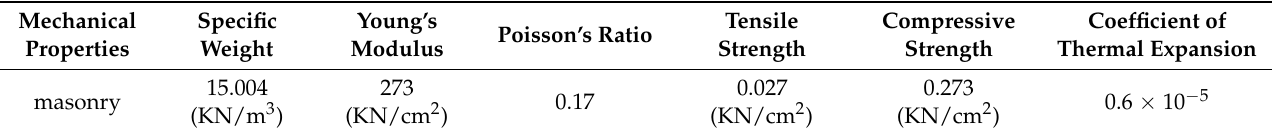
Table 3. Mechanical properties of Iranian masonry dome material. Data from Mehrdad Hejazi and his research group at the University of Isfahan [59,60].